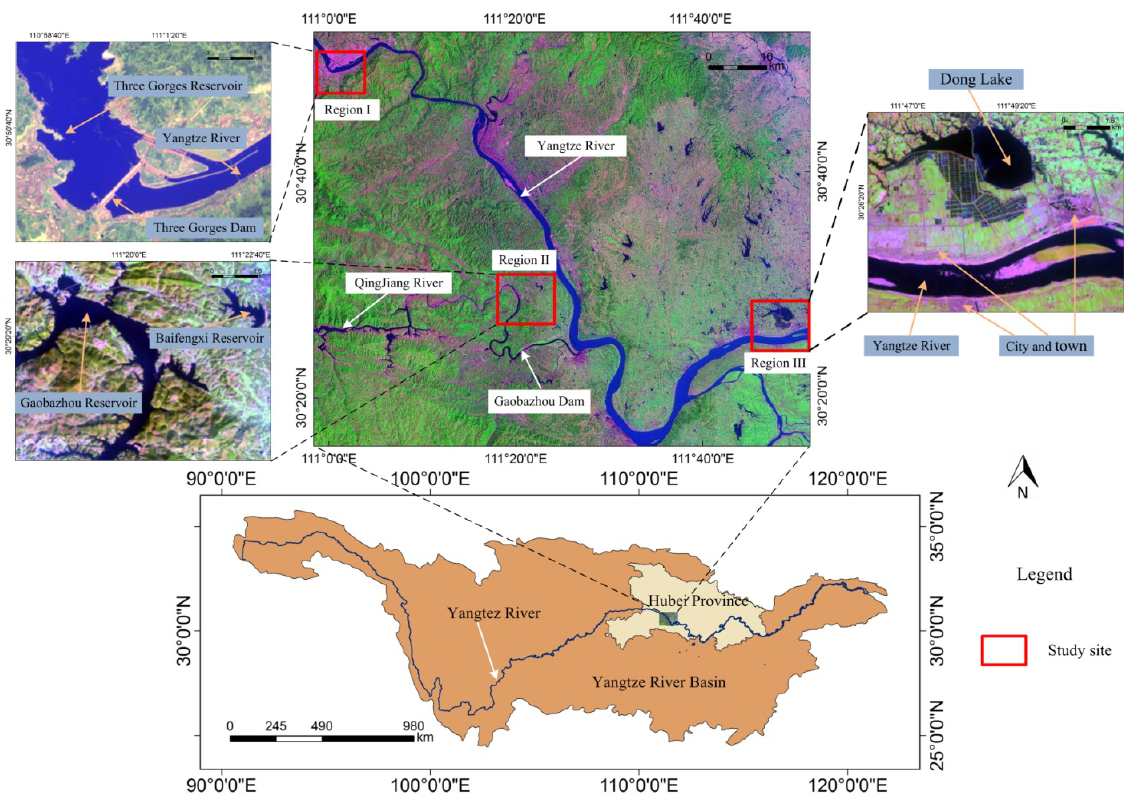
Figure 1. Location of the study